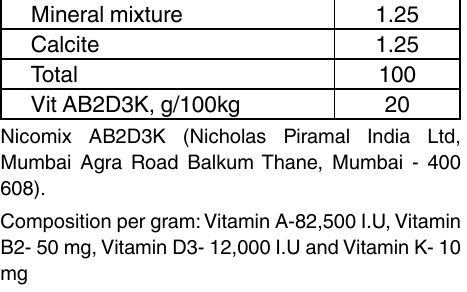
Composition per gram: Vitamin A-82,500 I.U,